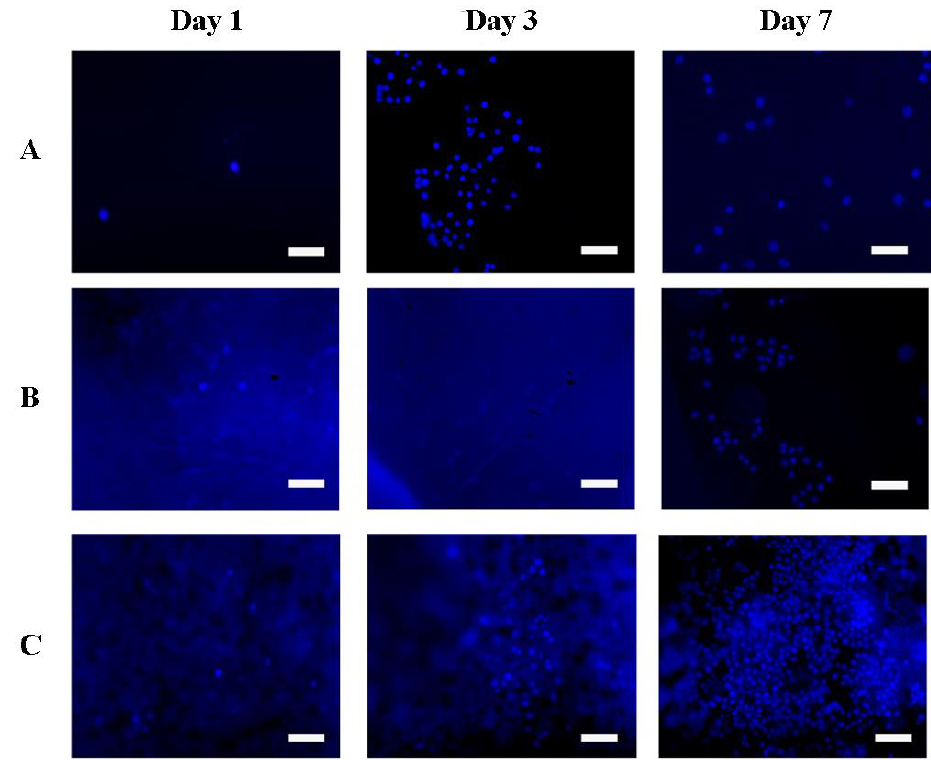
Figure 6. Data on cytotoxicity of scaffolds based on silk fibroin. Standard deviation values for five independent measurements are shown.